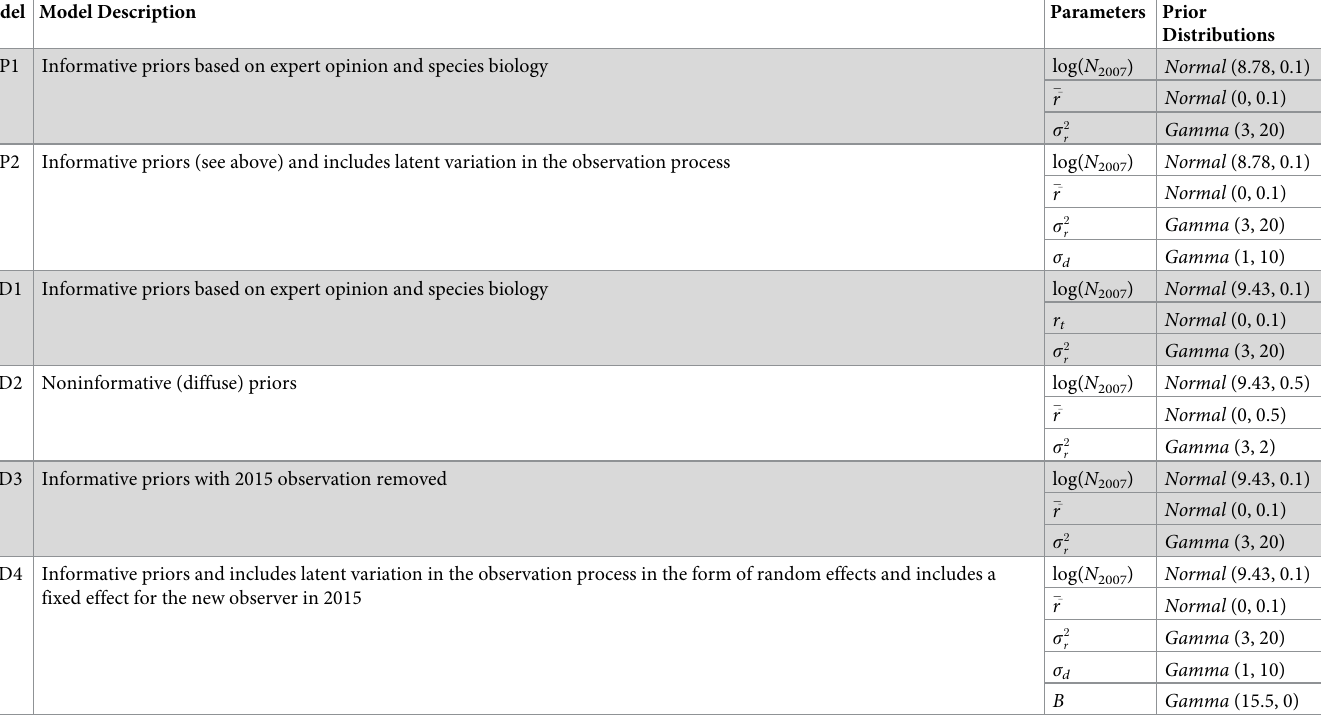
Table 2. Model descriptions, parameters, and prior distributions used to model population dynamics of spectacled eiders ( Somateria fischeri ) breeding on the Arc- tic Coastal Plain (ACP) and Yukon-Kuskokwim Delta (YKD). Model Model